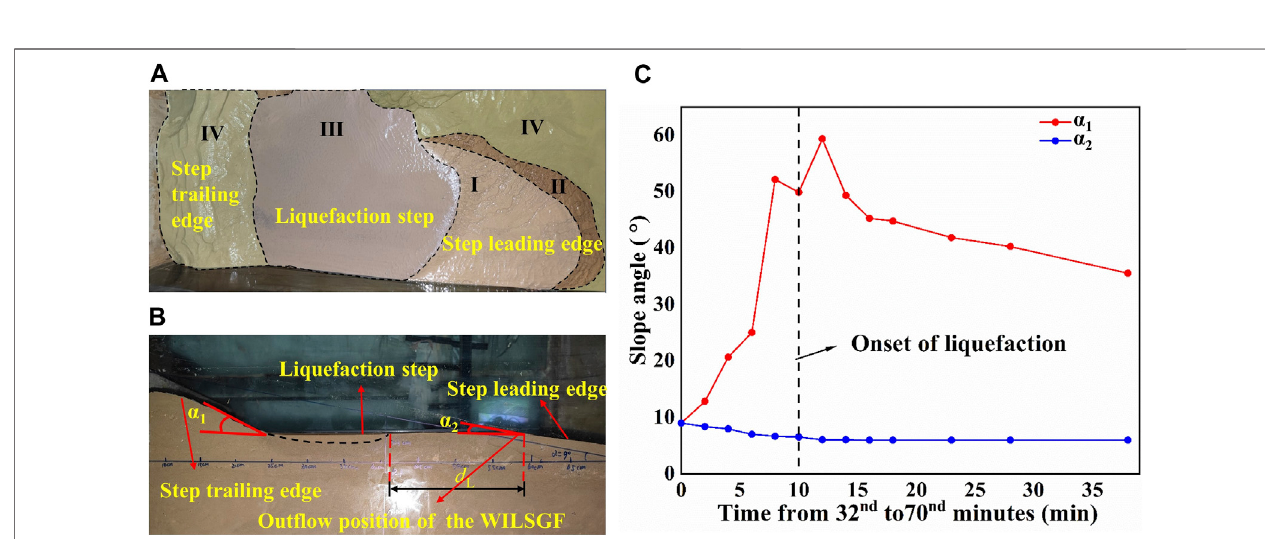
FIGURE 7 | Seabed morphological changes. (A) Top view of the sloping seabed. (B) Side view of the sloping seabed, where dL is the distance between the rightmost end of the liquefaction interface and the out fl ow location of the WILSGF, and α 1 and α 2 are the slope angle of the step trailing edge and step leading edge, respectively. (C) Slope change at the step trailing edge ( α 1) and step leading edge ( α